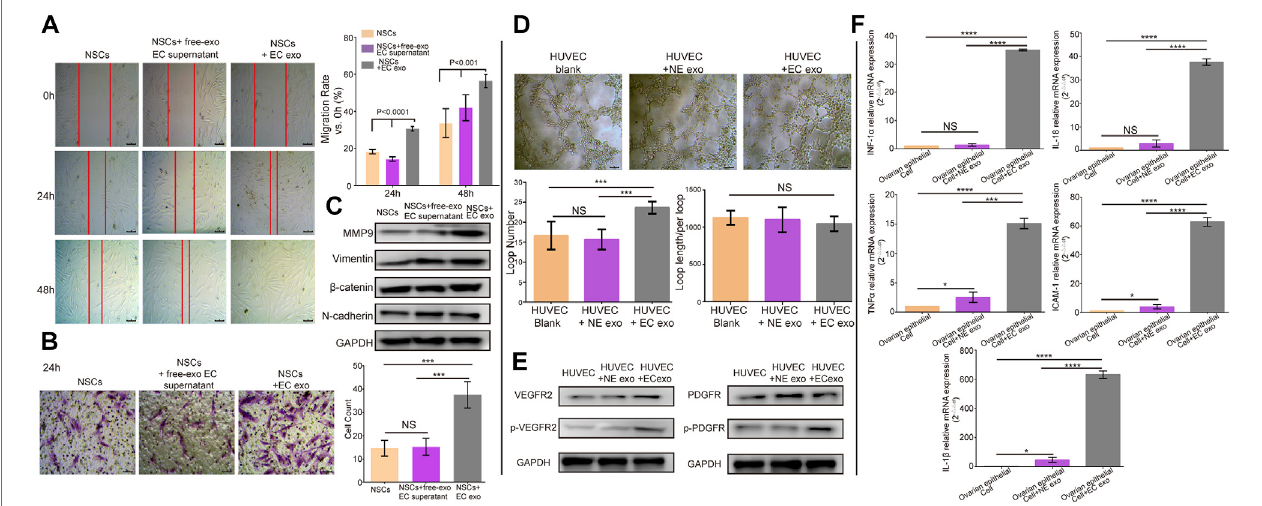
FIGURE 2 | ESCs-derived exosomes induced migration, angiogenesis, and upregulated in fl ammatory. (A) Wound-healing assay to verify the effects of exosomes on normal endometrial stromal cells (NSCs) migration. (B) Transwell assay to evaluate the migration ability, along with the quanti fi cation of migrated cells and migration rate. (C) Western blotting showed ectopic exosomes overexpressed MMP9, but there were no changes in the expression level of EMT- related proteins. (D) A tube formation assay along with quanti fi cation of the number of loops formed and loop length/per loop. (E) Western blotting analysis assessed the expression of VEGFR2,p-VEGFR2, PDGFR and p-PDGFR. (F) RT-qPCRtested the expression ofin fl ammatory cytokines, datawereexpressed asmean±SEM,NS,no signi fi cance, **** p <